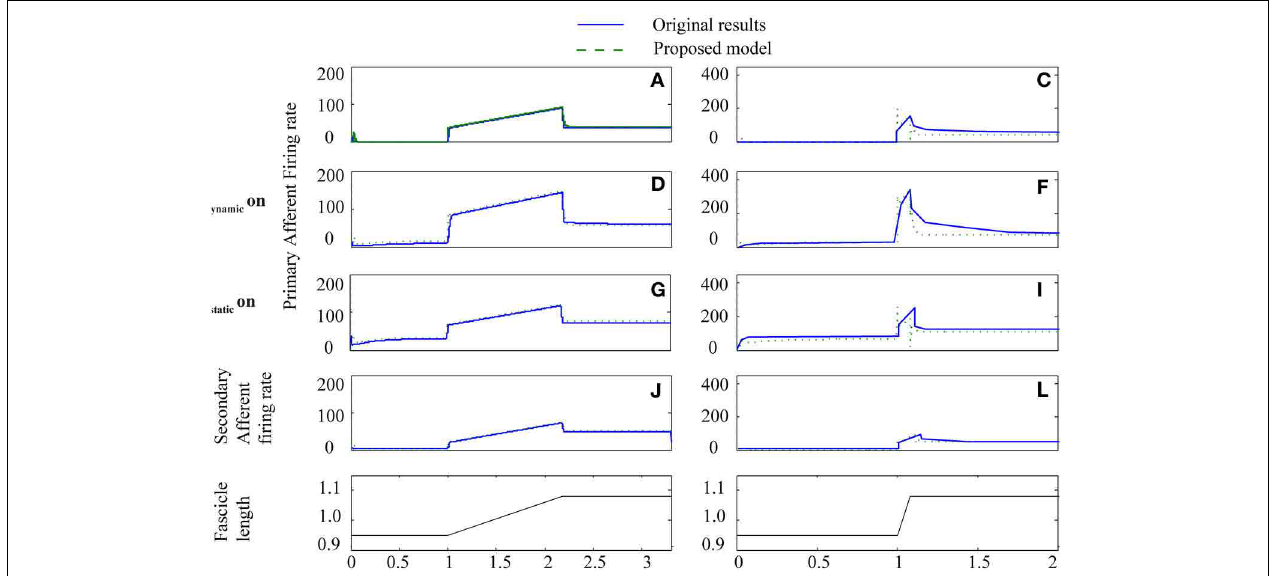
showing primary and secondary afferent firing in the presence or absence of static or dynamic fusimotor activation at 70pps. Labels are as in original paper.